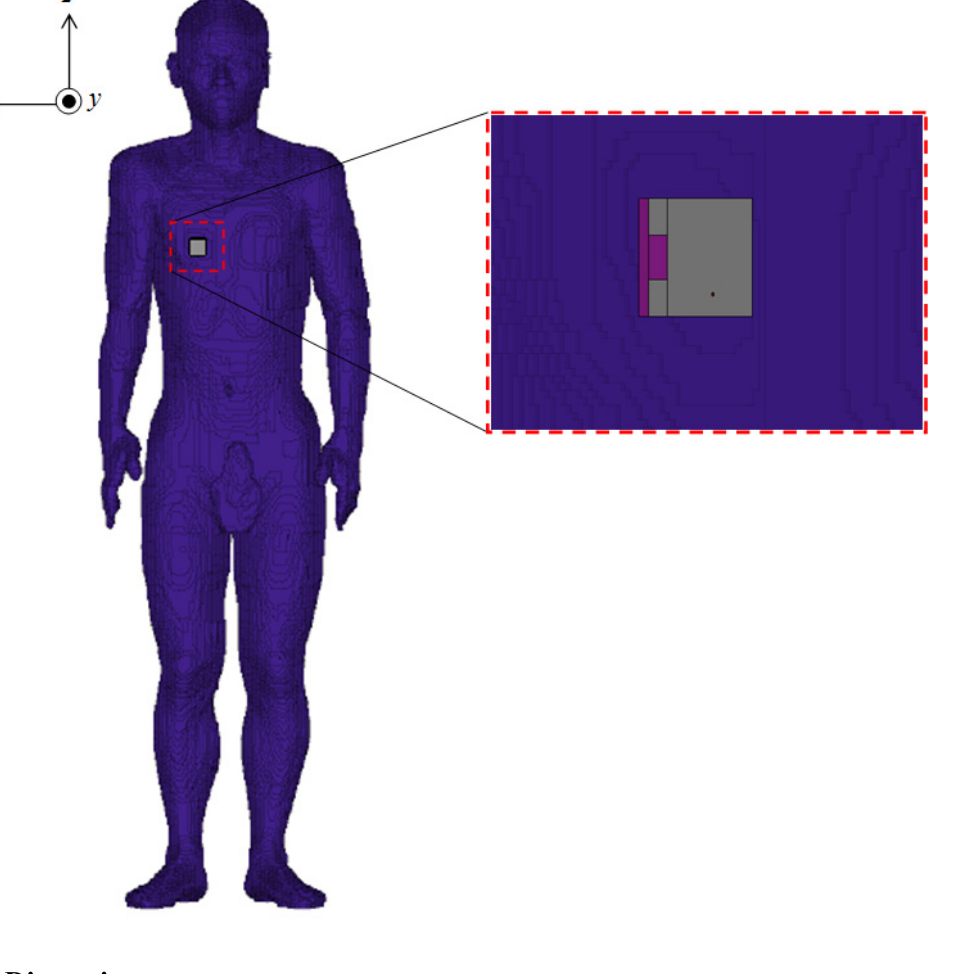
Figure 6. Proposed antenna on a high-resolution human